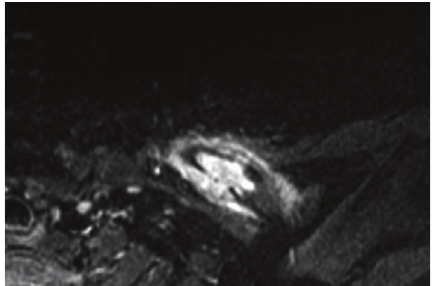
Figure 4: An axial STIR MR image shows a hyperintense mid- left clavicle lesion with periosteal reaction anteriorly. Moderate surrounding soft tissue hyperintense signal or edema is detected without discrete soft tissue mass or neurovascular invasion. The posterior cortical disruption is